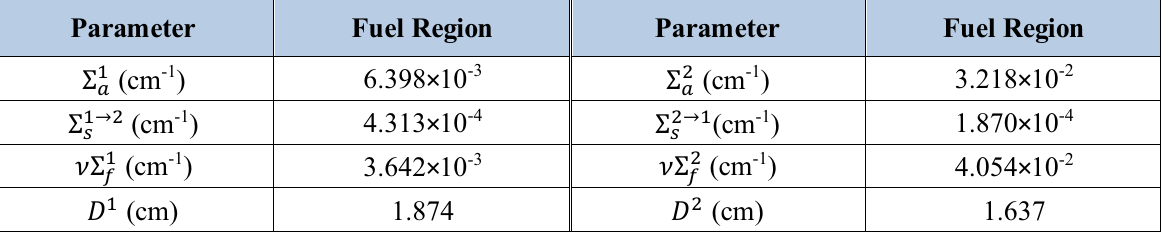
Table II. Nuclear Parameters for the PHWR Fuel Node under Voided